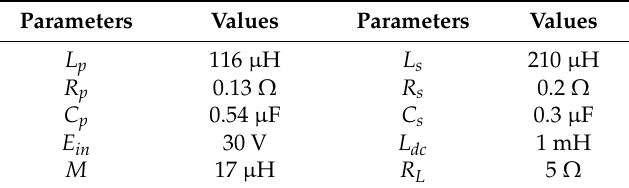
Table 3. Main simulation parameters of PS-type WPT system.